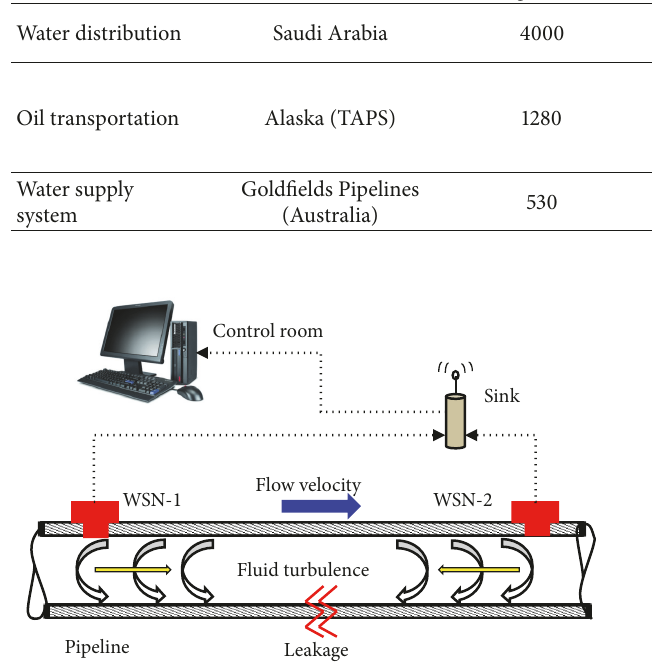
Figure 1: Schematic of pipeline monitoring wireless sensor net- works.